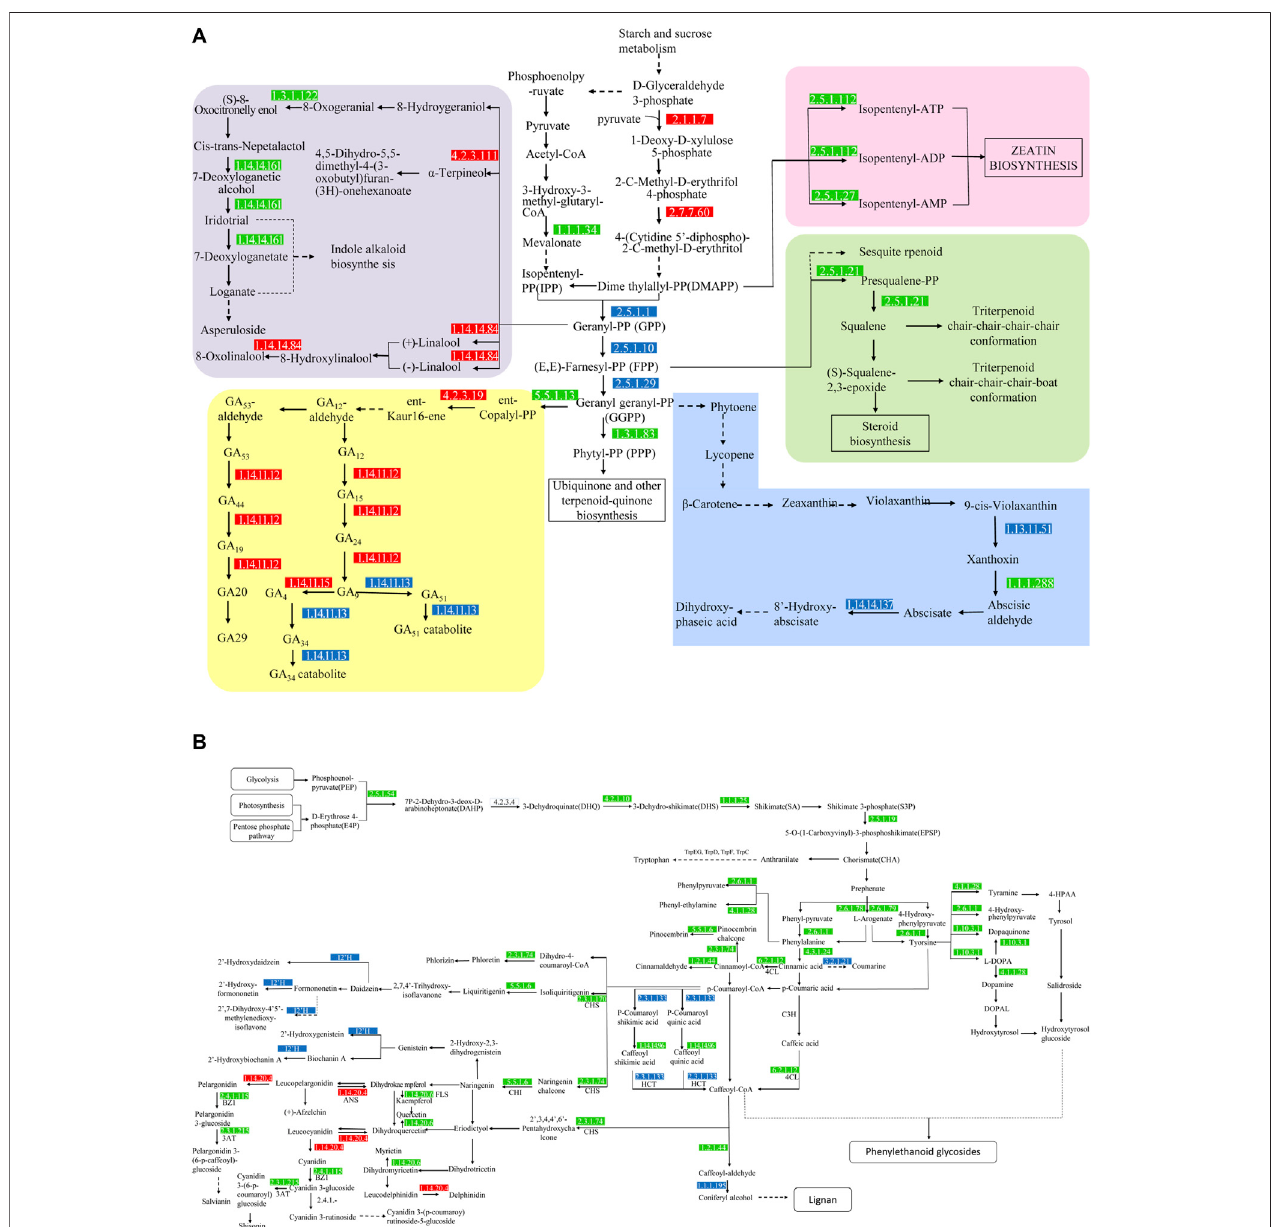
FIGURE8| Thebiosyntheticpathwaysand genesintheterpenoid (A) and fl avonoid (B) secondarymetabolitepathways.Thenumbersshown intheboxesarethe genes/genomesthatareenrichedintheKEGGpathwaythatregulateresponse.Theredboxindicatesthatthegeneisupregulated,thegreenboxindicatesthatthegene is downregulated, and the blue box indicates that the genome has up-regulated genes and downregulated genes. The solid line represents a single-step synthesis reaction and the dashed line represents a multi-step synthesis reaction.